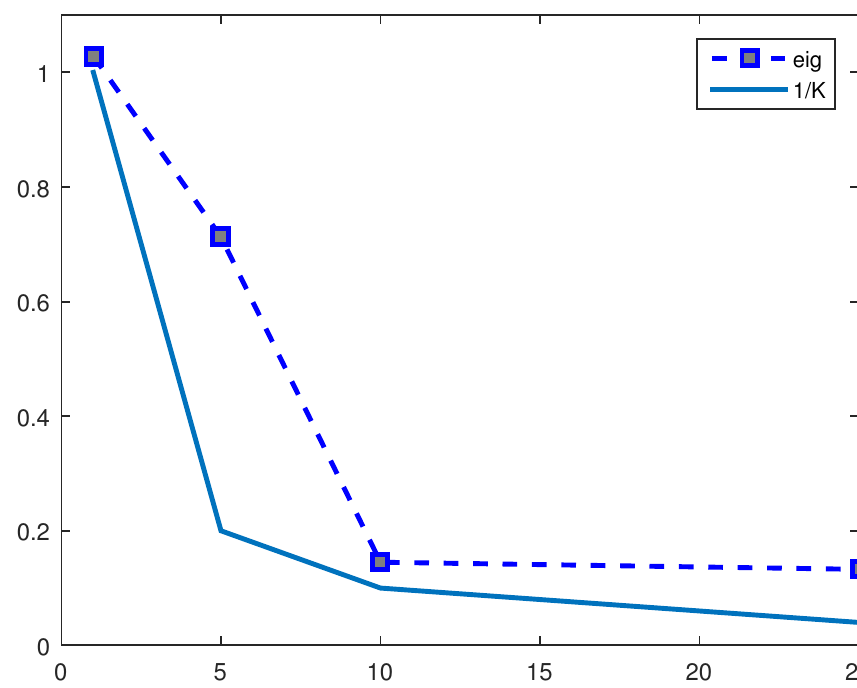
Figure 1. Standardized maximum eigenvalue of the posterior covariance matrix. Note: figure plots the standardized maximum eigenvalue of data cloning posterior the covariance matrix estimates against the 1/ K expected value for a well-identified